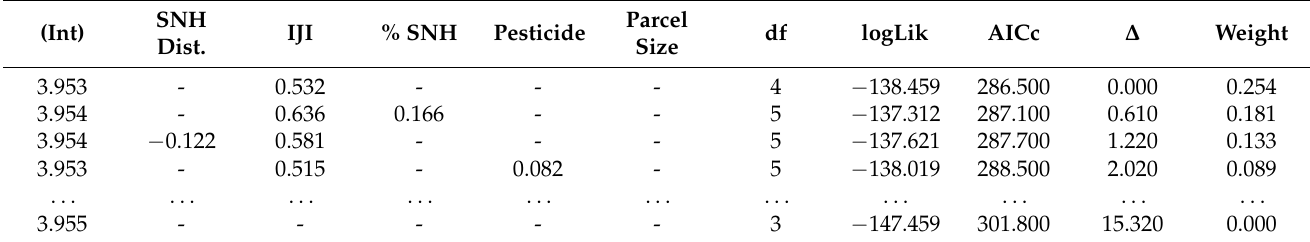
Table A3. Insect abundance model selection based on the comparison of their corrected Akaike Information Criterion-AICc with the dredge function (MuMin package of R version 4.0.2 2020-06-22).